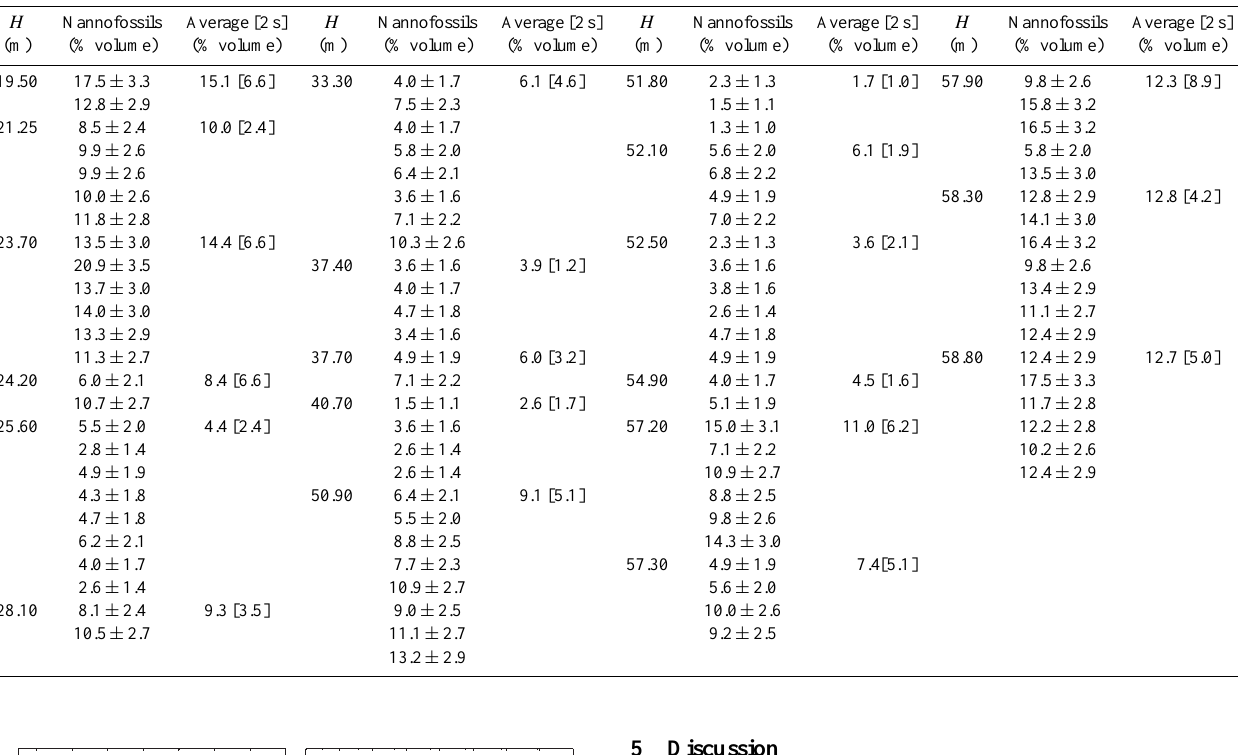
Table 2. Nannofossil content of analyzed limestones at Pignola-Abriola. Stratigraphic heights ( H ) as in Fig. 3. Each point count of column 2 (Nannofossils) refers to a framed SEM image; two-sigma confidence intervals are provided. The third column refers to the average of all images on which point counting was made for that sample. A figure of statistical dispersion (two standard deviations) is given between square brackets.